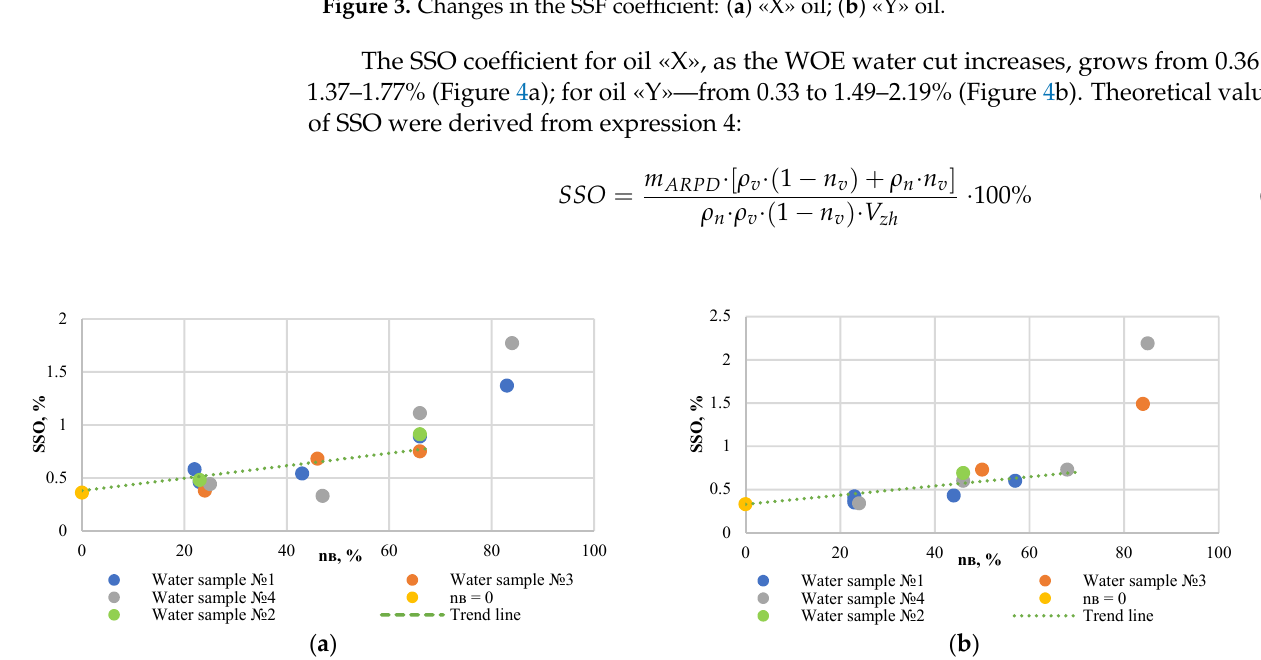
Figure 4. Changes in the SSO coefficient: ( a ) « Х » oil; ( b ) «Y» oil. The trend lines shown in these charts were obtained from the analysis of all laboratory test results. In the case of the SSO value, the dynamics of its changes for all oil and water samples correlate with the direction of the trend line. Moreover, it is worth noting a significant increase in the value under consideration that appears, most likely, during the formation of an oil-in-water emulsion. Such a significant increase in the value of oil dehydration for the studied oils must be associated firstly with the inclusion of the aqueous phase in the sediments. That process, combined with a decrease in the proportion of the oil phase, caused a significant increase in the indicator under consideration. The figures of sludging remain practically the same until the water cut reaches 60%, at which point the mineralization of the associated water included in WOE increased (Figure 5a,b).These figures also show trend lines, which are averaged values for water samples of a certain salinity. These trend lines slightly deviate from horizontal linearity, which confirms the lack of correlation between the parameters of sedimentation and salinity of the water phase. Noticeable or even significant variations of sludging values resulting from changes in the water cut are most probably connected with the technological error of tests (incomplete high-viscous emulsion running off the fingers before weighting). The rates of sludging in our investigation were evaluated by oil (RSO) and fluid (RSF) coefficients: